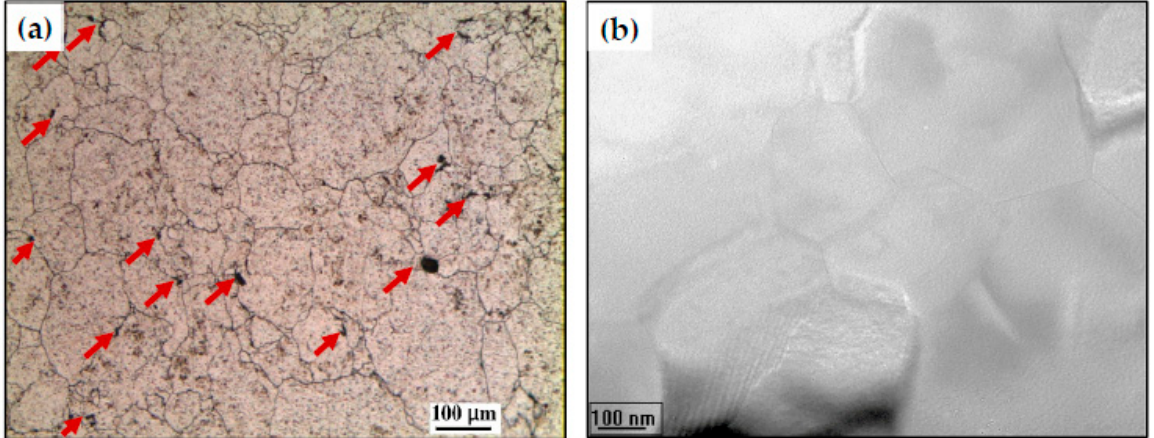
Figure 4. ( a ) Optical microscope micrograph of PM Al sample and ( b ) TEM micrograph bright field of HPT Al sample.